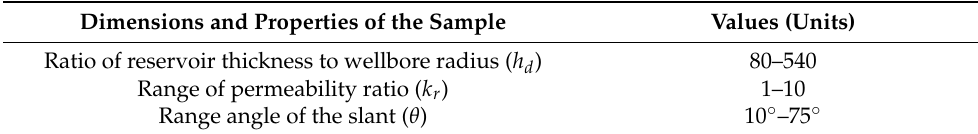
The flow rate for vertical wells in cylindrical near-wellbore regions with anisotropy permeability and Darcy flow perpendicular to the wellbore is expressed